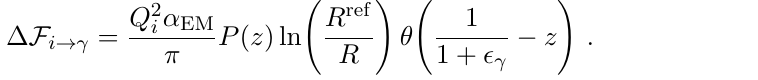
the non-perturbative fragmentation, a key difference between the two functions is that for fixed-cone isolation, the inside part of the function depends on the cone radius.